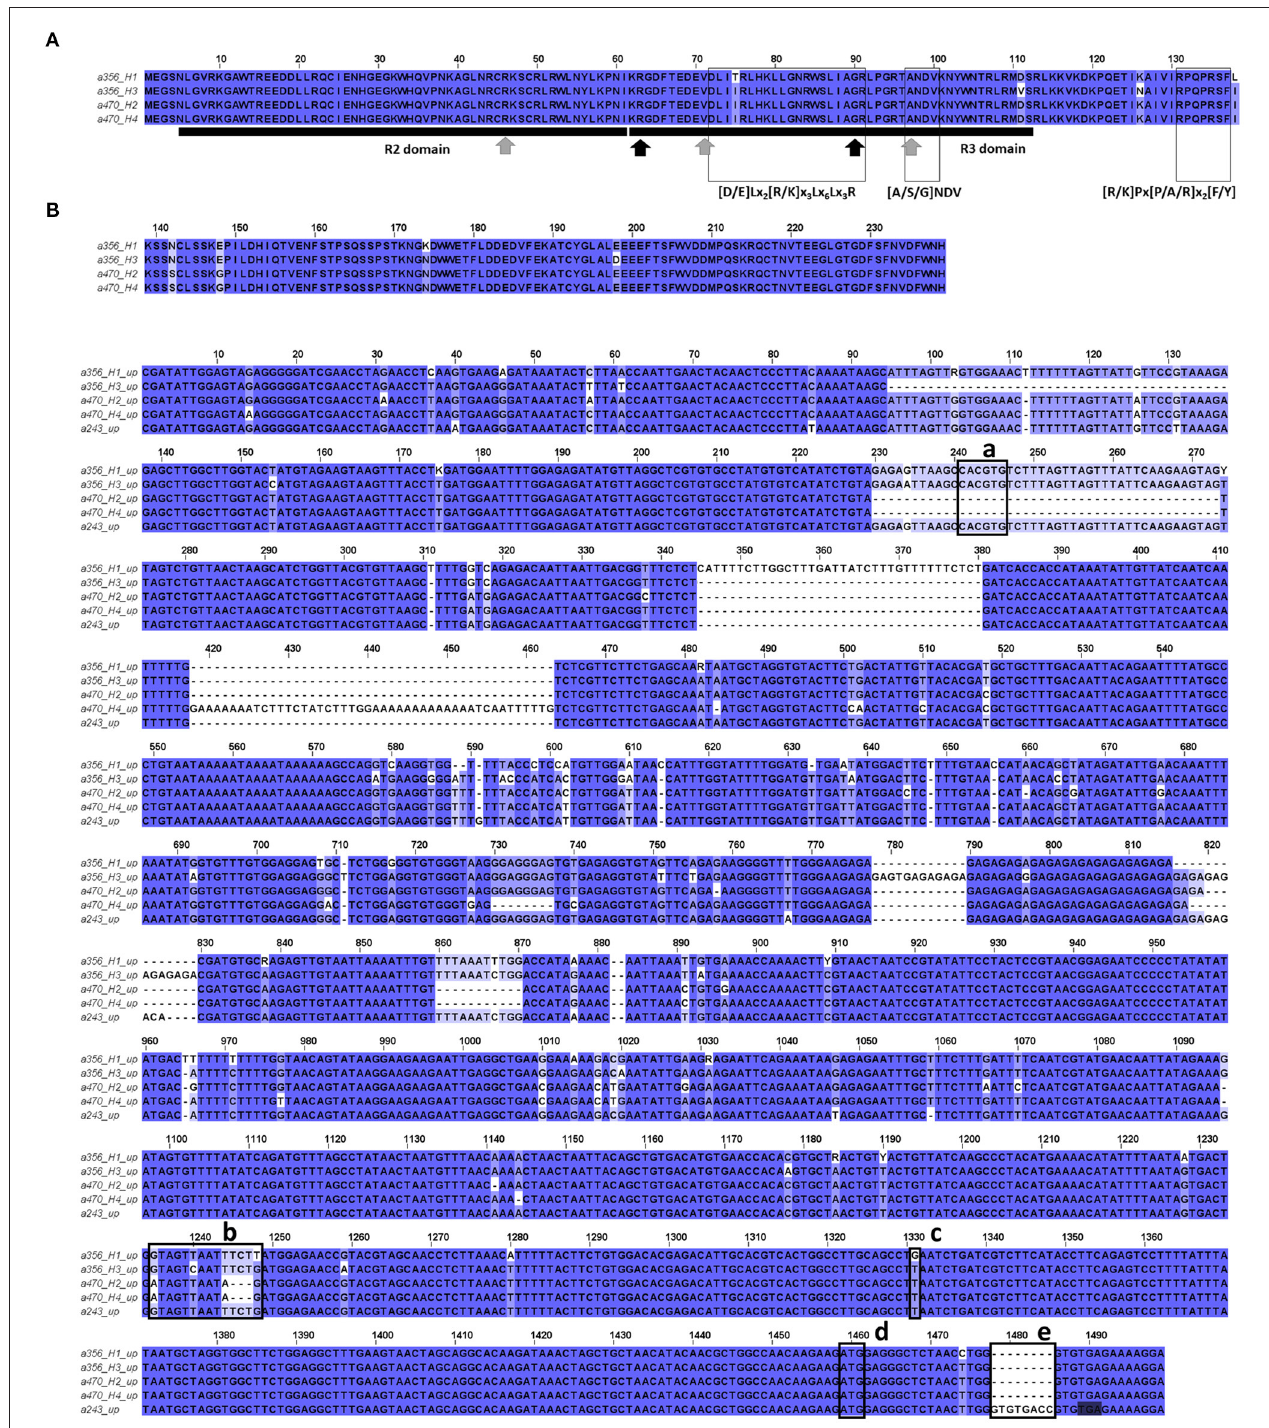
FIGURE 5 | (A) Alignment of PsMYB10.1 in silico translated proteins from a whole-gene sequence. Conserved amino acids (gray arrows) and signature motifs ([A/S/G]NDV; [R/K]Px[P/A/R]x2[F/Y]) from R2R3-MYB anthocyanin-promoting proteins from Rosaceae were detected in all PsMYB10.1 sequences (Lin-Wang et al., 2010). Conserved motif [D/E]Lx2[R/K]x3Lx6Lx3R indicates a possible interaction with basic-helix-loop-helix (bHLH) proteins. Black arrows indicate key residues in PpMYB10.1 function (Zhou et al., 2018). (B) Polymorphisms found between a356 H1 , a356 H3 , a470 H2 , a470 H4, and a243 upstream sequences: (a) G-box motif in the 44 bp indel; (b) polymorphisms in the R1-motif (Espley et al., 2009); (c) SNP S3_12879559 (Salazar et al., 2017); and (e) 8 bp insertion in exon 1 of a243, 4 bases before an in-frame STOP codon (shadowed). The start codon is marked as (d).